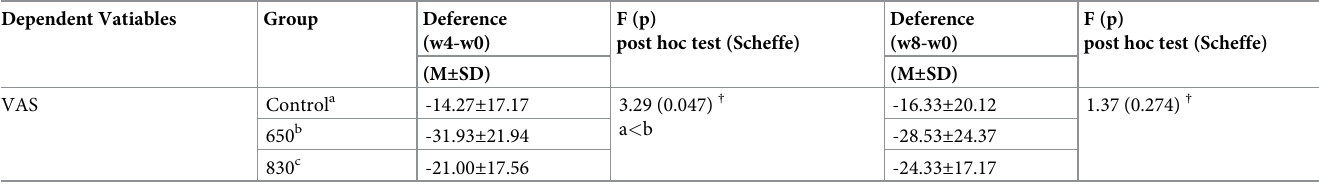
Table 4. Difference in changes in VAS scores among three groups (n = 45).